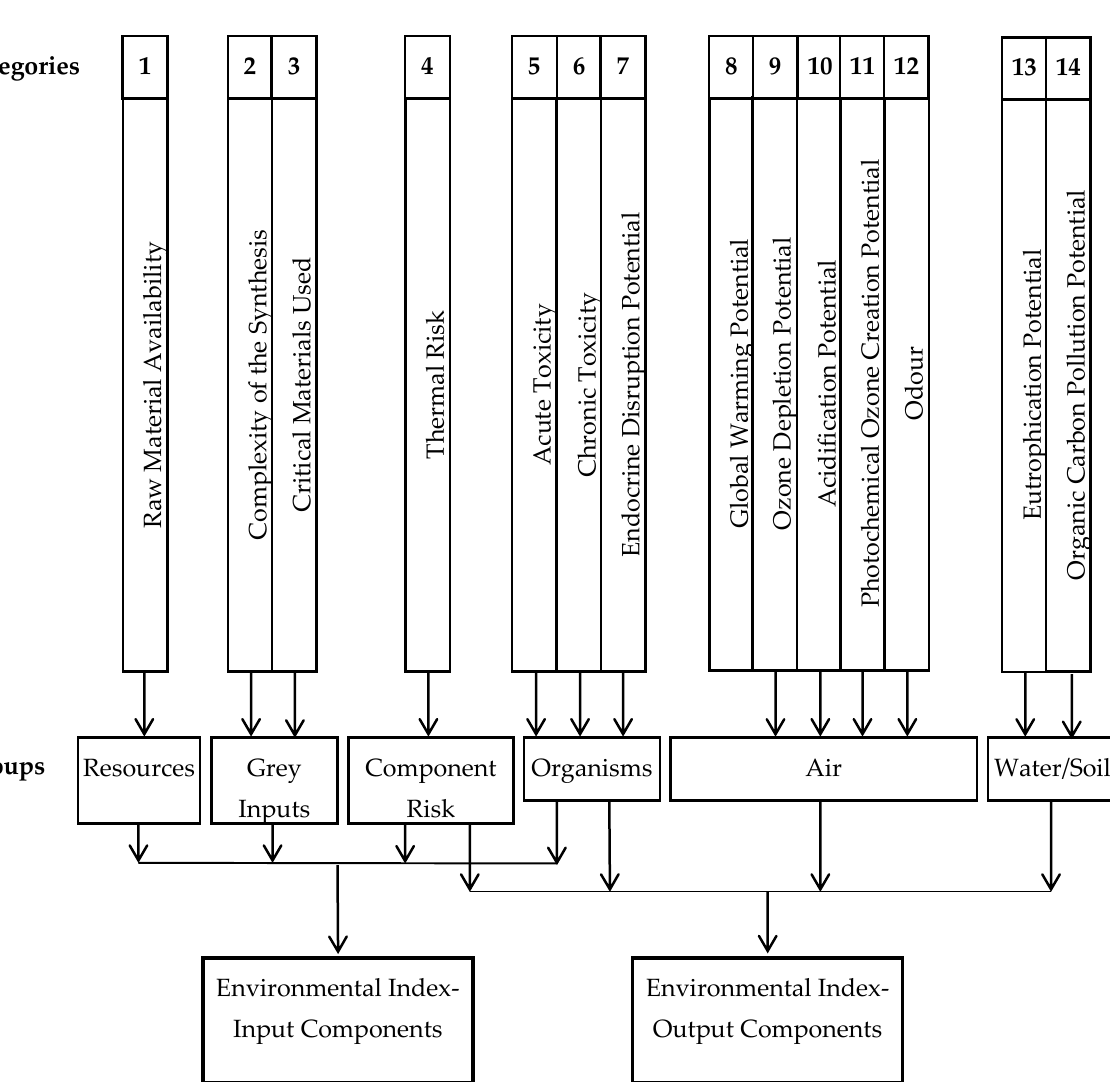
Table 3. Input impact assessment.